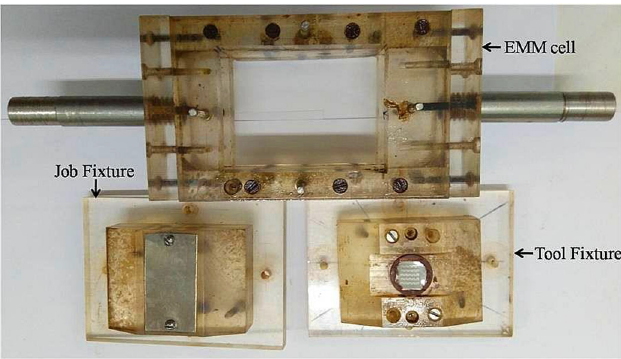
Fig. 2. Developed maskless EMM cell with tool and workpiece fi xtures.